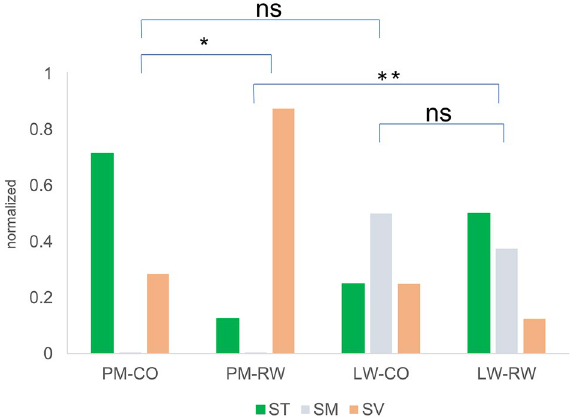
Figure 3. Group comparison of array scalar positioning. Scala media or scala vestibuli position is assigned if at least one electrode-contact was located in the respective compartment. *p < 0.05, **p < 0.01. ST scala tympani, SM scala media, SV scala vestibuli.